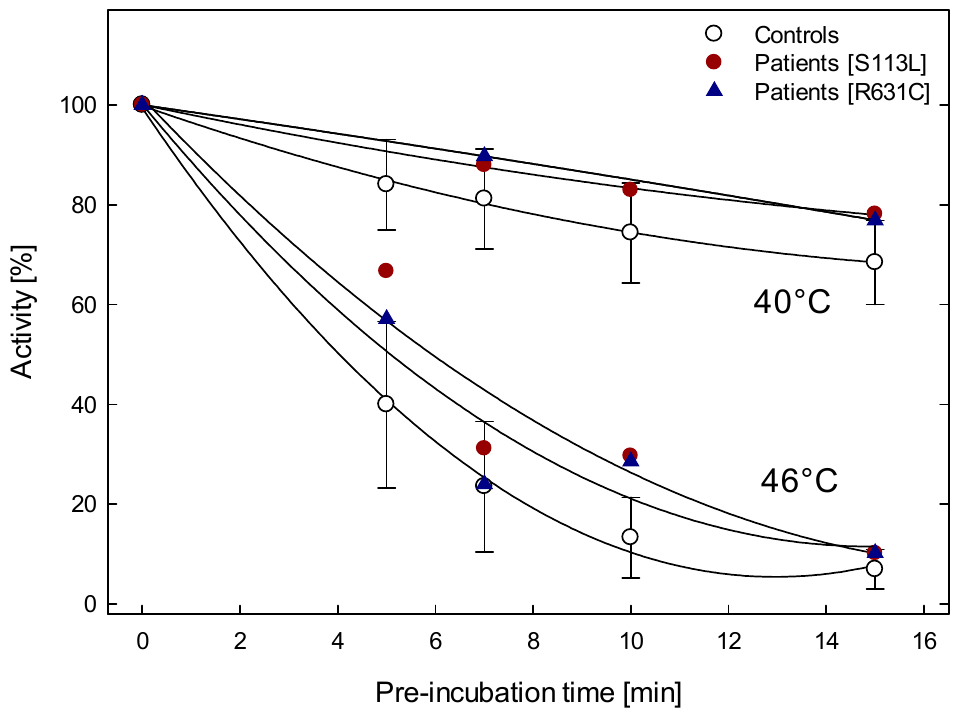
Figure 2. CPT activity in muscle homogenates of wild-type and patients with pre-incubating at 40 °C [wild-type (n = 5) and mutant (n = 4); p.Ser113Leu (n = 3) and p.Arg631Cys (n = 1)] and 46 °C [wild-type (n = 8) and mutant (n = 4); p.Ser113Leu (n = 2) and p.Arg631Cys (n = 2)] for up to 15 min. The error bars correspond only to data of the wild-type. Table 2. Effect of cardiolipin (CLP) (0.25 mM) on CPT II activities in muscle homogenates of controls and patients with the p.Ser113Leu and p.Arg631Cys variants. Values are expressed as the ratio of the activity with over without pre-incubation with CLP for 7 and 15 min at 40 ◦ C and 46 ◦ C. The number of patients are given in parentheses. The data of controls are shown as mean ( ± SD) and the data of patients are shown as means wherever